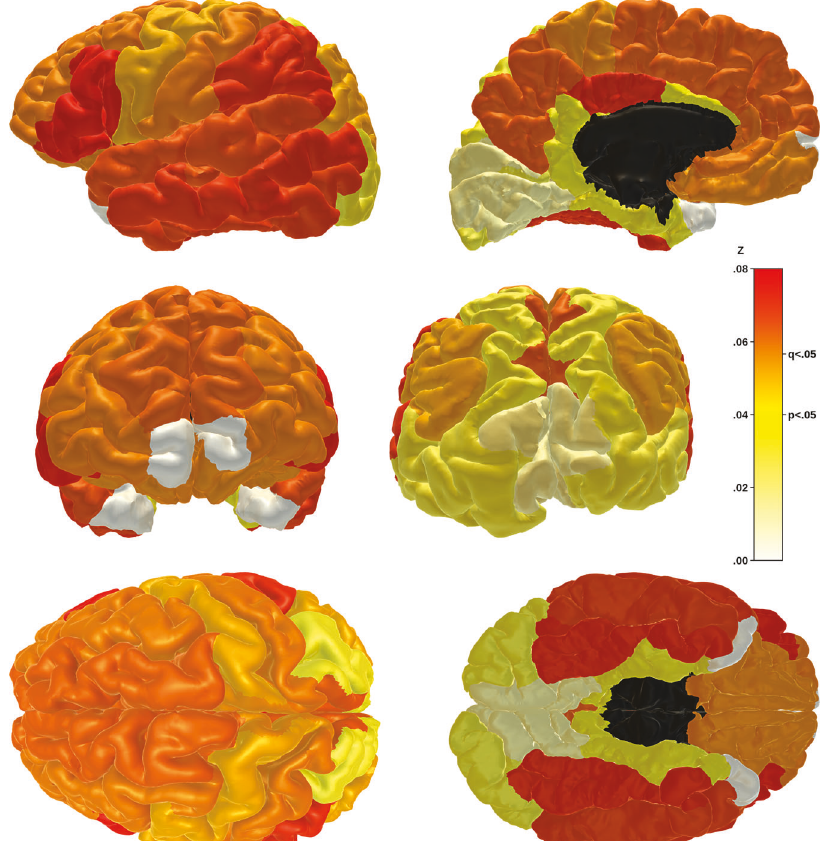
Fig. 3 Phenotype effects on associations between lifetime depression and cortical thickness by region. Notes . Phenotype effects for each region represent the difference, assessed using z-tests, between the two most disparate of the β coef fi cients for the three phenotypes ’ associations with cortical thickness of that region. Effects range from z = 0.00 (pale yellow) to z = 0.08 (bright red). Associations and effects for frontal and temporal pole regions (white) were not calculated. Z statistics for plotted results are reported in Supplementary Materials (Table